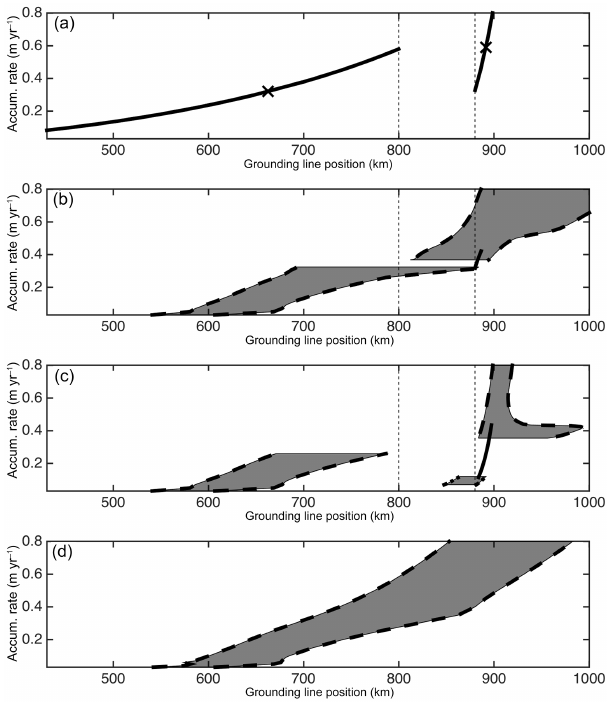
Figure 2. Stable equilibrium grounding-line positions and limit cy- cle grounding-line oscillation amplitudes as function of accumula- tion rate a c . Solid lines indicate stable equilibrium grounding-line positions. Shading bounded by dashed lines indicates range over which grounding line oscillates. (a) Bed properties are static with τ c = 0kPa everywhere ( b x r = 2 × 10 − 4 ). (b) Bed properties dy- namically evolve ( b x r = 2 × 10 − 4 ). (c) Bed properties dynamically evolve ( b x r = 10 − 3 ). (d) Bed properties dynamically evolve with no retrograde section. In panels (a)–(c) x 0 = 800km and L = 80km and location of retrograde section is indicated by vertical dashed lines. “x” marks indicate location of steady states for simulations plotted in Fig.